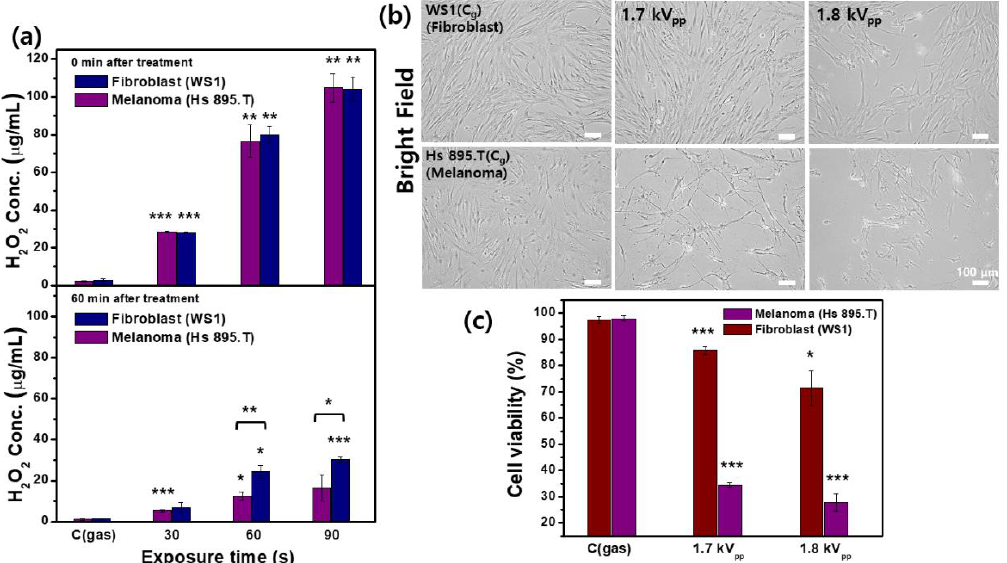
Figure 7. CAP induces the increased level of intracellular hydrogen peroxide (H 2 O 2 ) and suppresses the cell viability in a dose-dependent manner in cancer cells. ( a ) Extracellular hydrogen peroxide (H 2 O 2 ) concentration as a function of treatment time in the presence of cancer (Hs 895.T) and non-cancerous (WS1) cells (upper row, 0 min after treatment; bottom row, 60 min after treatment). ( b ) Brightfield images of cells (upper row, WS1 (fibroblasts); bottom row, Hs 895.T (melanoma)) and ( c ) cell viability measured by MTS assay at 24 h after CAP treatment (gas-treated, 1.7 and 1.8 kV pp ). Each point represents the mean ± SD of three replicates. Scale bar indicates 100 μm. *, p < 0.05; **, p < 0.01; ***, p < 0.001. * p < 0.05 was considered statistically significant.